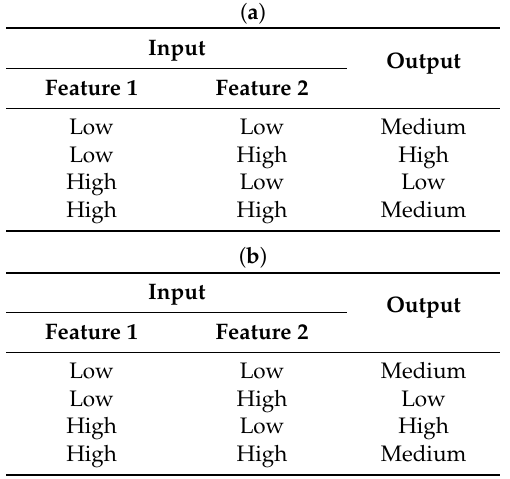
Table 2. Fuzzy rule table. Rule tables for pedestrians ( a ) and for non-pedestrian features ( b